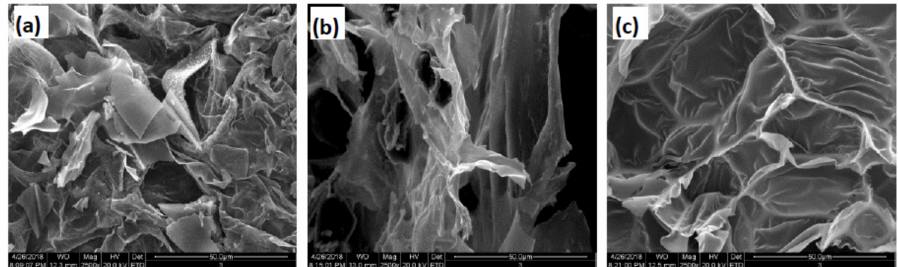
Figure 8. SEM of residual char with 2500 × zoom, including: ( a ) S D8 , ( b ) S D8+graphene , and ( c ) S D8+mGO